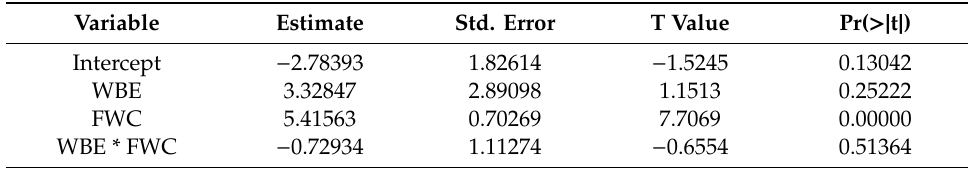
Figure 7. The foaming performance of 35 / 50 penetration bitumen as a function of foaming water and WBE contents: expansion ratio ( a ), half-life ( b ). Table 11. Statistical analysis of the model predicting ERm of 35 / 50 foamed bitumen based on the foaming water content, WBE content, and their interaction.